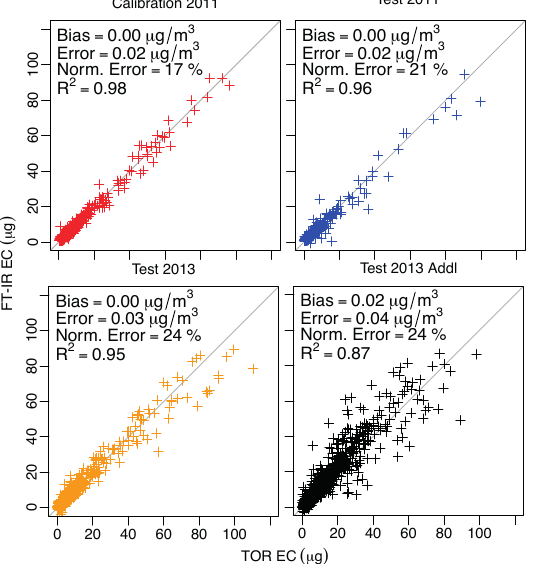
Figure 8. Scatter plots and performance metrics between FT-IR EC and TOR EC for the four data sets described in Sect. 2.1. Concentra- tion units of µgm − 3 for bias and error are based on the IMPROVE nominal volume of 32.8m 3 .